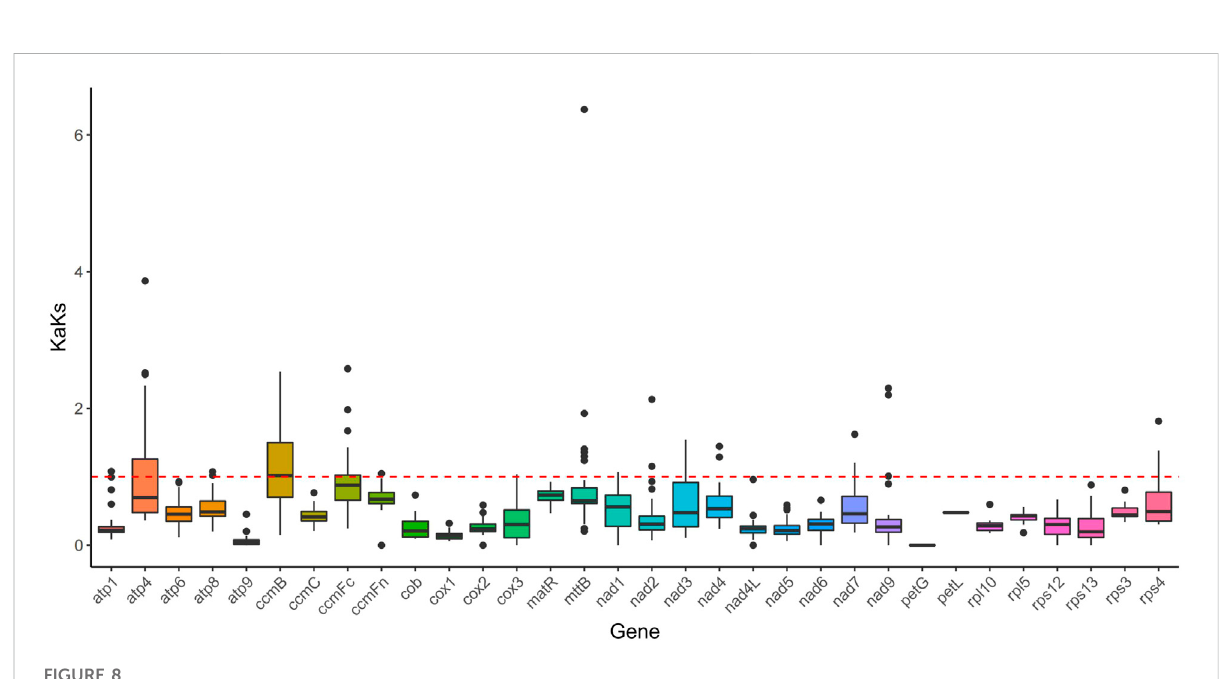
FIGURE 8 KaKs analysis of the MCB